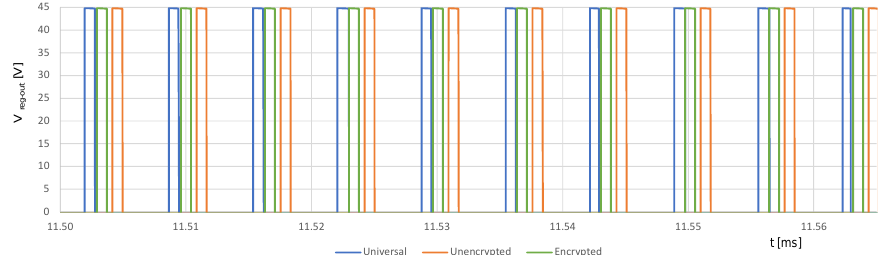
Figure 27. V reg-out LM2594 models time graph curves.